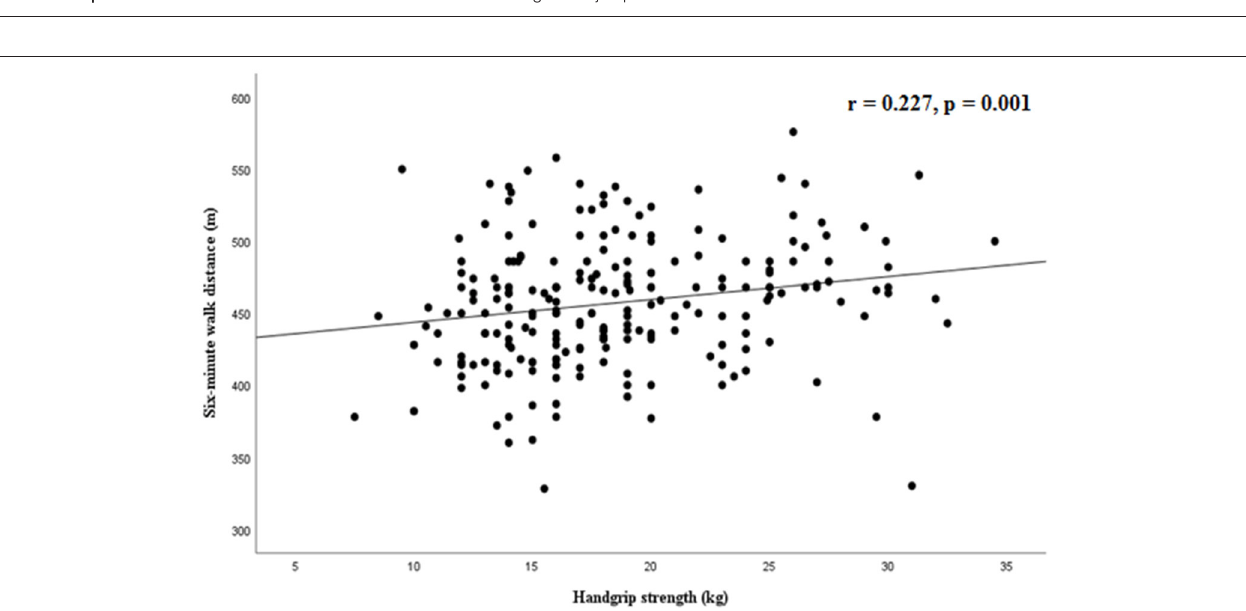
FIGURE 2 | Correlation between six-minute walk distance and handgrip